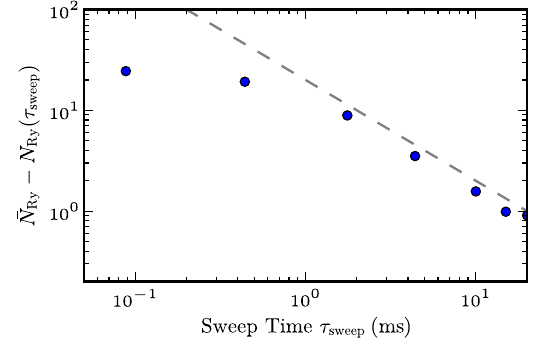
FIG. 15. Mismatch between the equilibrium Rydberg excitation ¯ N number and the Rydberg excitation number N Ry . We use the same parameters as in a finite sweep time τ sweep = Γ without Fig. 7(b). The hysteresis scan starts at Δ = 2 π ¼ 40 MHz and stops sp ex at Δ = 2 π ¼ 10 MHz. The dashed line indicates a scaling ∝ τ − 1 = Γ . sp ex